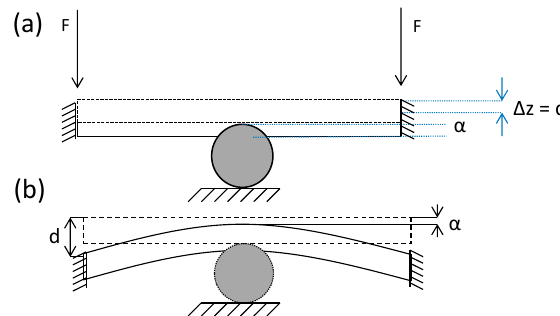
Figure 1. Mechanical contact between a plate and a sphere. ( a ) Schematic illustration showing the indentation and no bending produced in the plate; ( b ) indentation measurement principle during a contact experiment with the presence of bending.